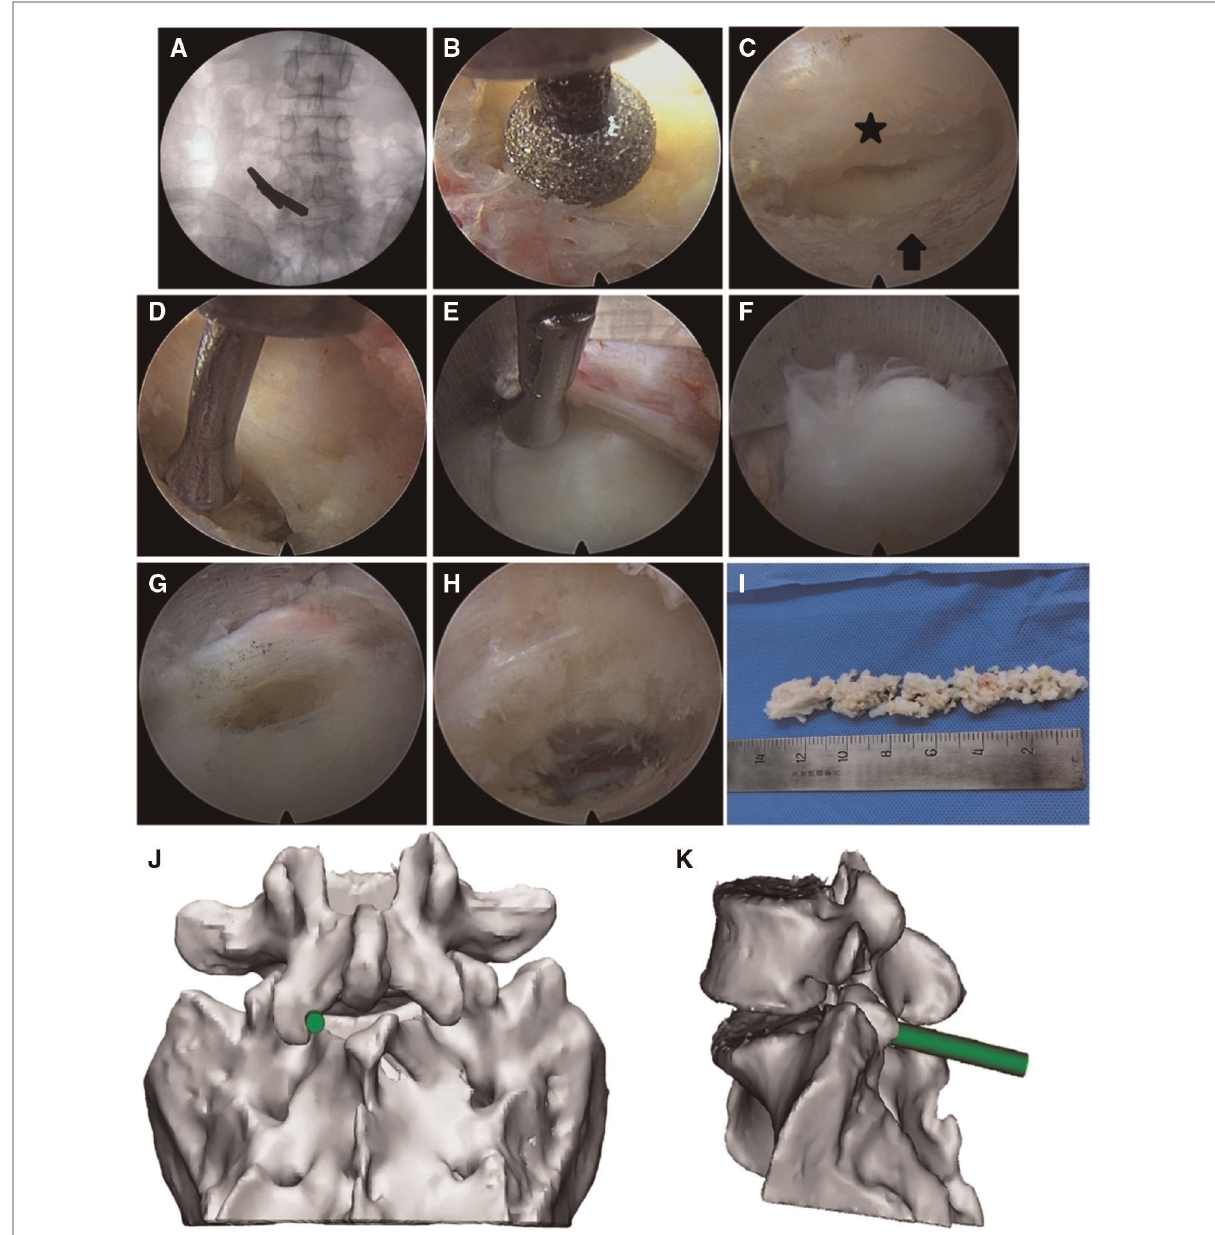
FIGURE 3 Percutaneous endoscopic lumbar discectomy via the medial foraminal approach in a 40-year male with L5 – S1 disc herniation. ( A ) The dilator was localized using fl uoroscopy before surgery and placed close to the medial articular process. ( B ) A portion of the medial articular process was removed by drilling to expose the attachment site of the ligamentum fl avum. ( C ) The ligamentum fl avum (star) was separated from the articular process (arrow). ( D ) The ligamentum fl avum, dural sac, and nerve root were retracted medially by the adjustable nerve dissector. ( E ) The tip of the ligule groove of the working cannula was closely attached to the annulus fi brosus at the lateral disc along the medial articular process. By rotating the cannula, the ligamentum fl avum, dural sac, and nerve root were moved to the center of the spinal canal. ( F ) Herniated nucleus pulposus. ( G ) The herniated nucleus pulposus was removed through the opening in the disc. ( H ) Following extraction of the herniated nucleus pulposus, the working cannula was retracted to the surface of the annulus fi brosus. The ligamentum fl avum was mostly preserved, although some portions remained attached at the external margin. ( I ) The extracted nucleus pulposus tissue. ( J,K ) Schematic presentations of the working cannula in frontal ( J ) and side ( K )